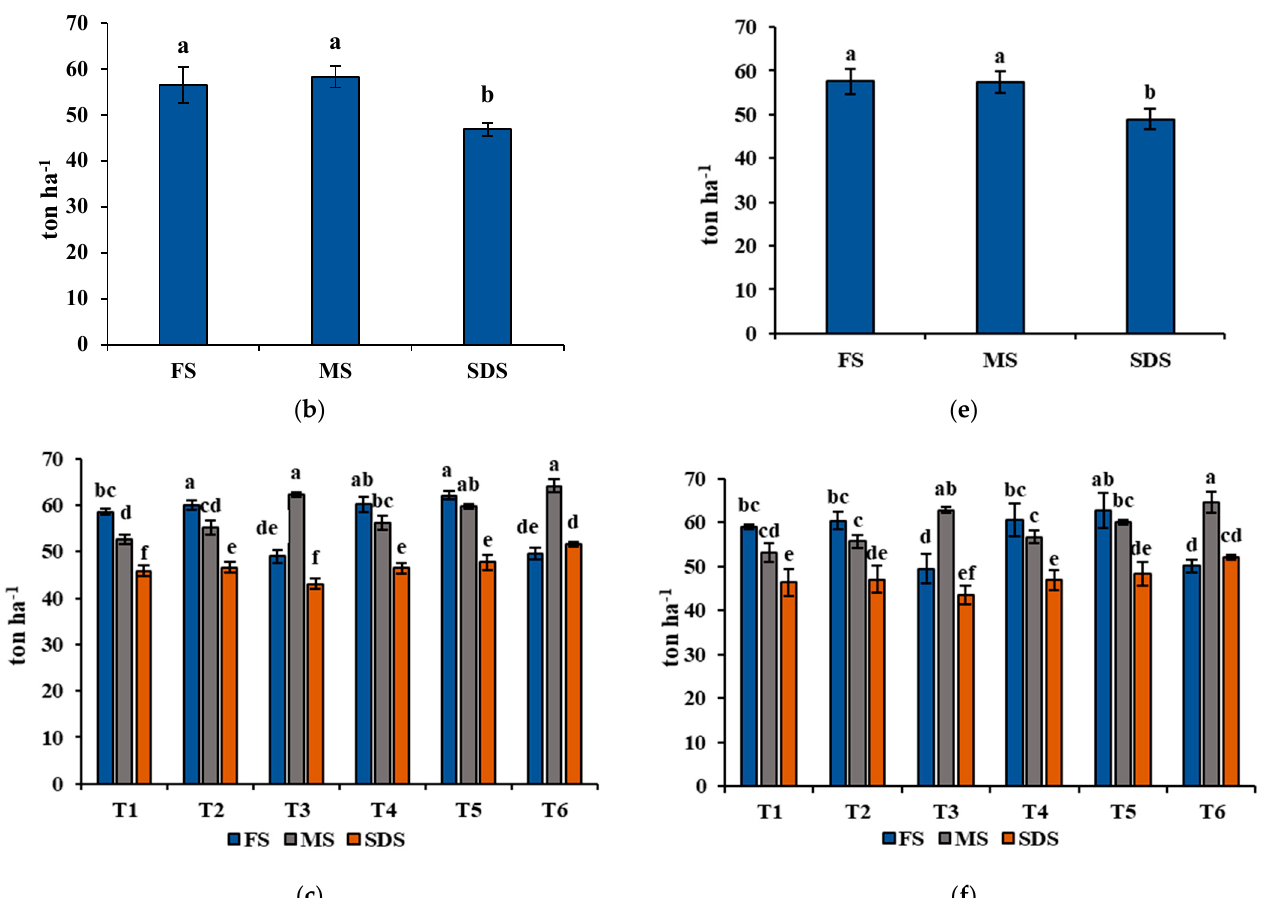
Figure 3. Agronomic parameter, fresh biomass yield (FBY) collected during both growing seasons. Explanations: ( a ) treatment (year 2020); ( b ) harvesting times (year 2020); ( c ) interaction between treatment and harvesting times (year 2020); ( d ) treatment (year 2021); ( e ) harvesting time (year 2021); ( f ) interaction between treatment and harvesting times (year 2021). The treatment is specified as follows: T1 = wheat cultivar 1 (Xiaoyan 17) sole cropping; T2 = wheat cultivar 2 (Baomai 9) sole cropping; T3 = ryegrass sole cropping; T4 = wheat cultivar 1 (Xiaoyan 17) with alfalfa mixed cropping; T5 = wheat cultivar 2 (Baomai 9) with alfalfa mixed cropping; T6 = ryegrass with alfalfa mixed cropping, and the harvesting time is indicated as FS = harvested at flowering stage of cereal (wheat); MS = harvested at milk stage of cereal (wheat); SDS = harvested at soft dough stage of cereal (wheat). Different letters show significant differences at p < 0.05. Bars point to the standard deviation.